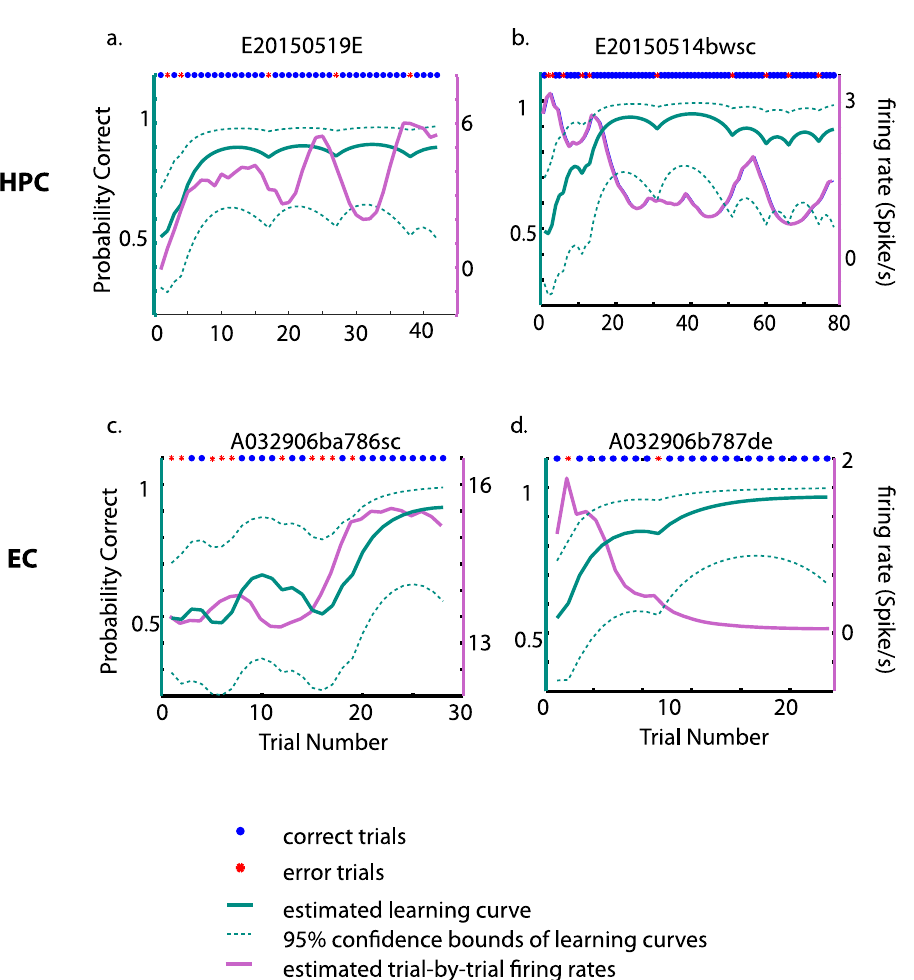
Fig. 5 Estimated learning curves and fi ring rates of example changing cells. The estimated trial-by-trial fi ring rates (purple lines) superimposed on estimated learning curves (teal lines) of an example sustained changing cell in HPC was plotted in a , a baseline sustained changing cell in b , an example sustained changing cell in EC in c , and a baseline sustained changing cell in d . The blue- fi lled circles on top of each subplot indicate correct trials and the red asterisks indicate the error trials. The 95% con fi dence bounds of estimated learning curves were plotted in teal dashed lines. The trial-by-trial fi ring rates plotted here were estimated with the same state-space algorithm used to estimate behavioral performance 33 to avoid the dif fi culty of recognizing the correlation between the fi ring rates and the behavior performances due to the noisy neural spiking with inherited variability. Performances are shown in Supplementary Data